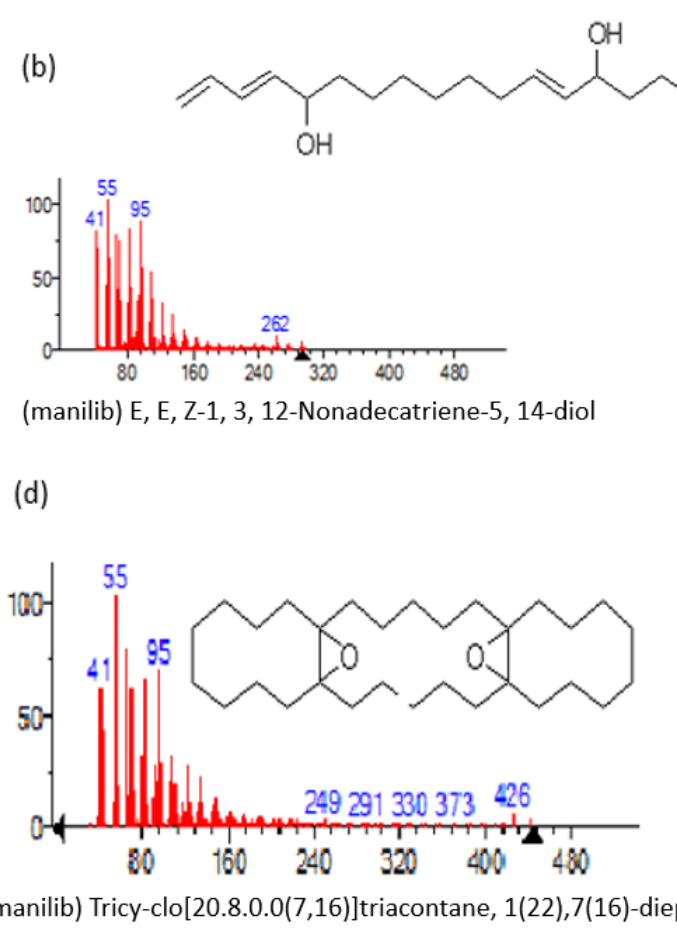
Figure 5. Representing the mass spectrum of 18-Pentatriacontanone with RT = 96.417 ( a ), E, E, Z-1, 3, 12-Nonadecatriene-5,14-diol with RT = 99.402 ( b ), 9-Octadecenoic acid (Z)-, 9-octadecenyl ester, (Z) - with RT = 103.82 ( c ), and Tricyclo [20.8.0.0(7, 16)] triacontane, 1(22), 7(16)-diepoxy- with RT = 104.247 ( d ).